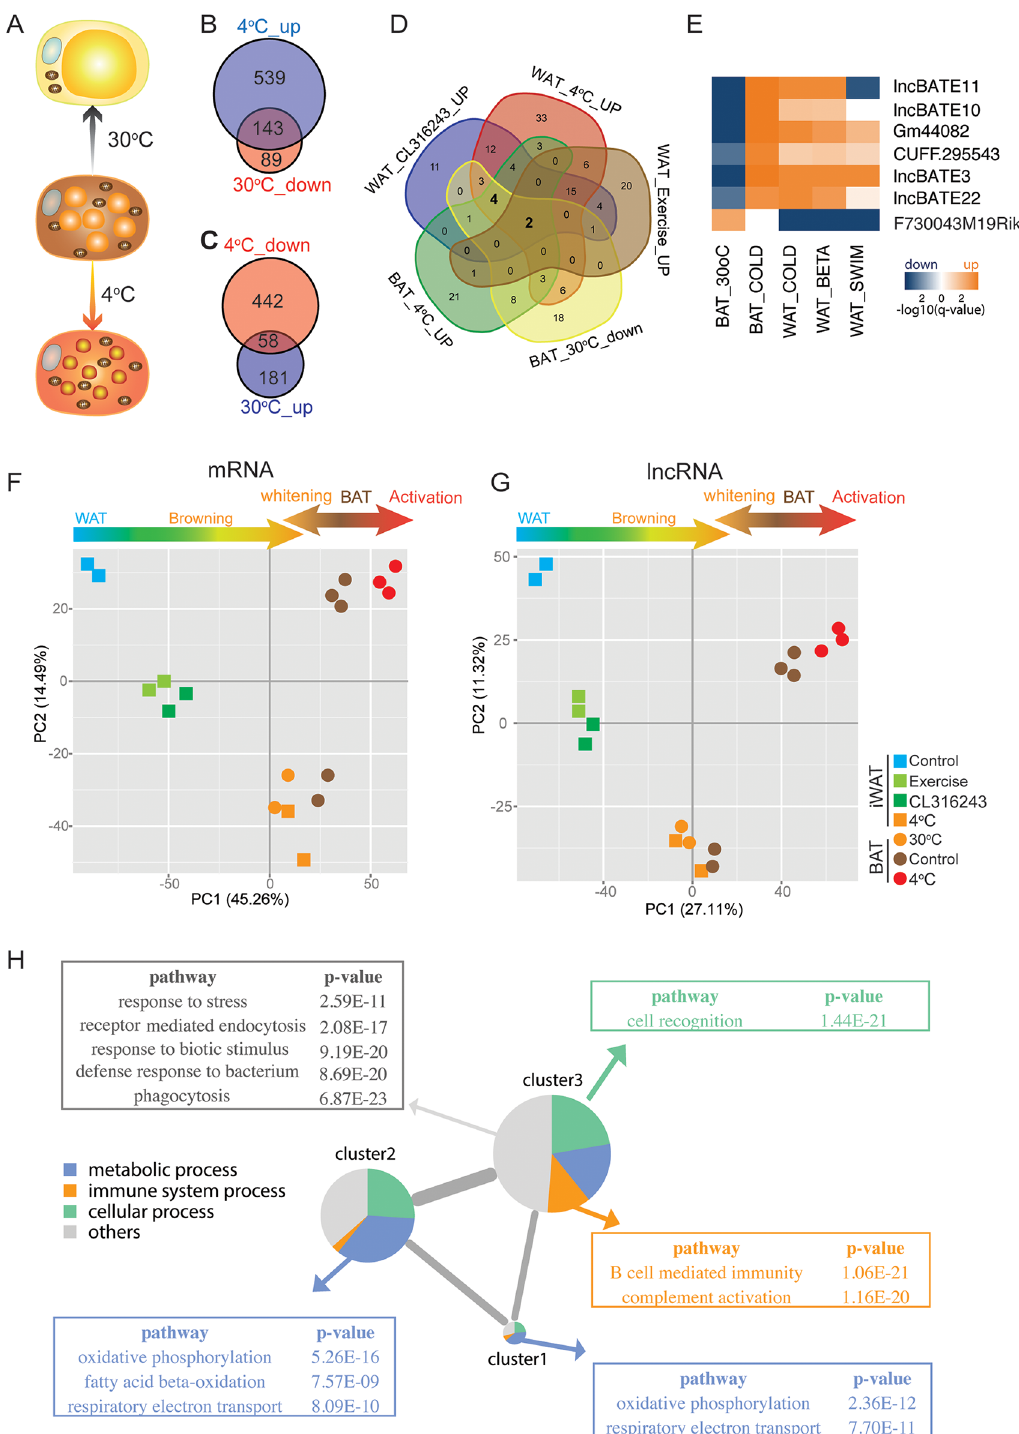
Fig 2. Gene and network expression in browning and whitening studies. (A) Schematic representation of cellular transitionsin brown adiposetissue (BAT) due to cold (4˚C) or warm exposure(30˚C). (B,C) Comparison of the overlap betweendifferentiallyexpressedgenesdue to contrastingthermal shifts in BAT. Genes (mRNAs) up-regulated at 4˚C are compared to genes down-regulated at 30˚C (B) and vice versa (C). (D) Five-way Venn diagramcomparingthe overlap amongsignificantlyup-regulated long noncodingRNAs (lncRNAs) due to browning-inducing treatments in white adiposetissue (WAT) and cold exposurein BAT, and lncRNAs significantly down-regulatedin BAT due to